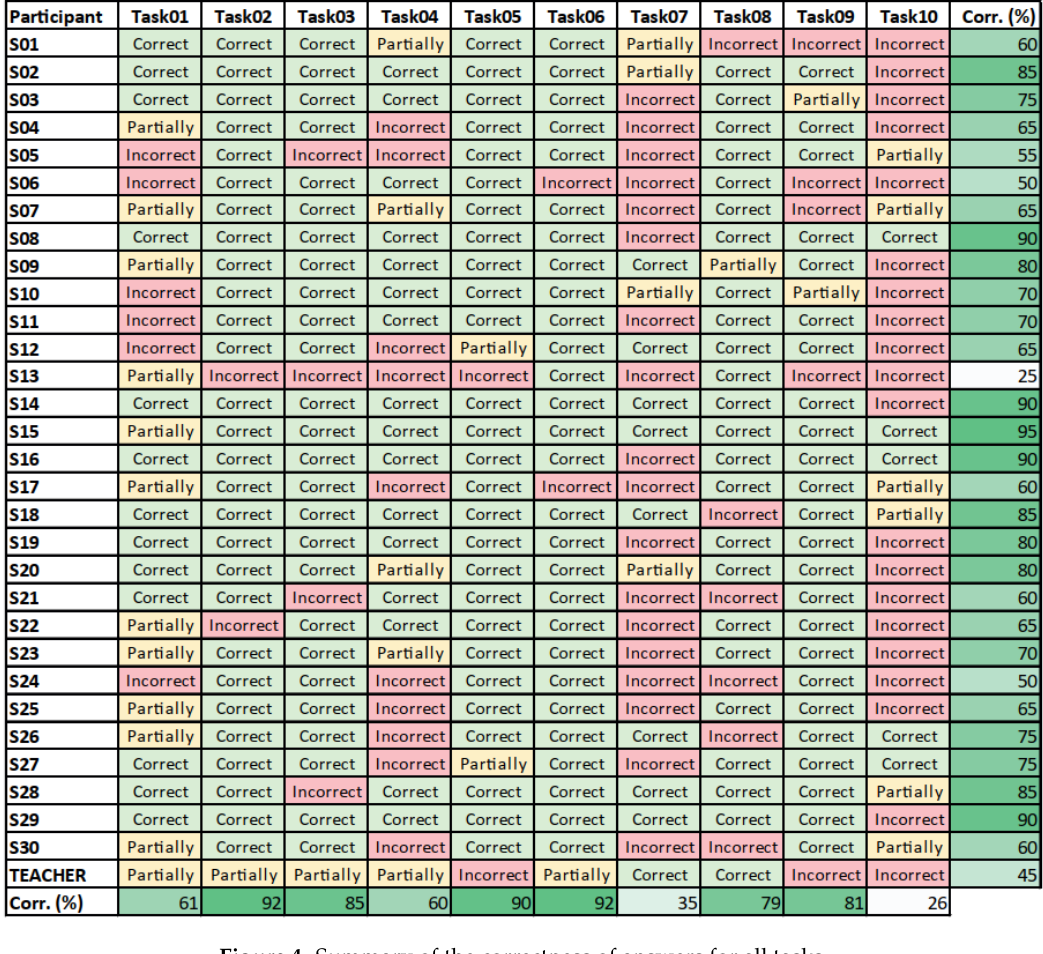
Figure 4 . Summary of the correctness of answers for all tasks. Figure 4. Summary of the correctness of answers for all